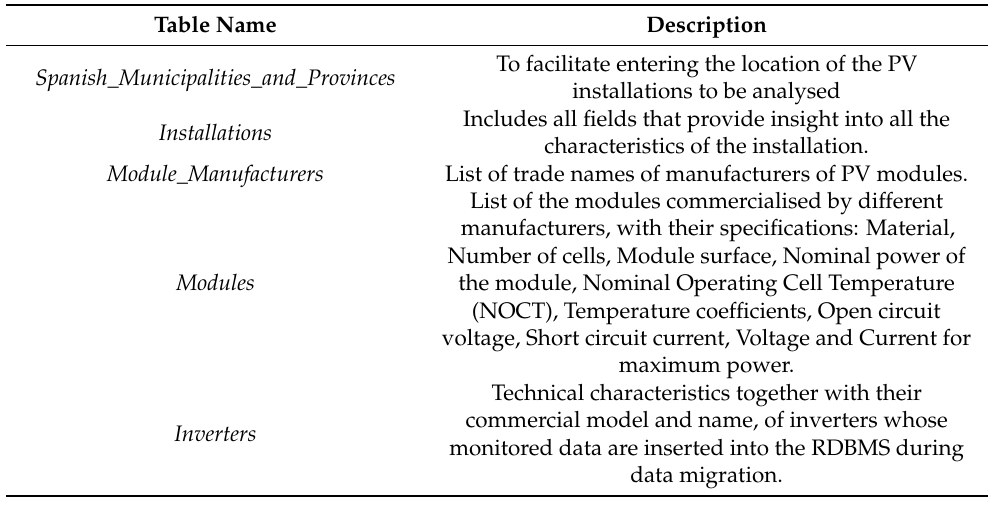
Figure 6. Schematic diagram representing the structure of the RDBMS. Table 4. Main tables included in the common